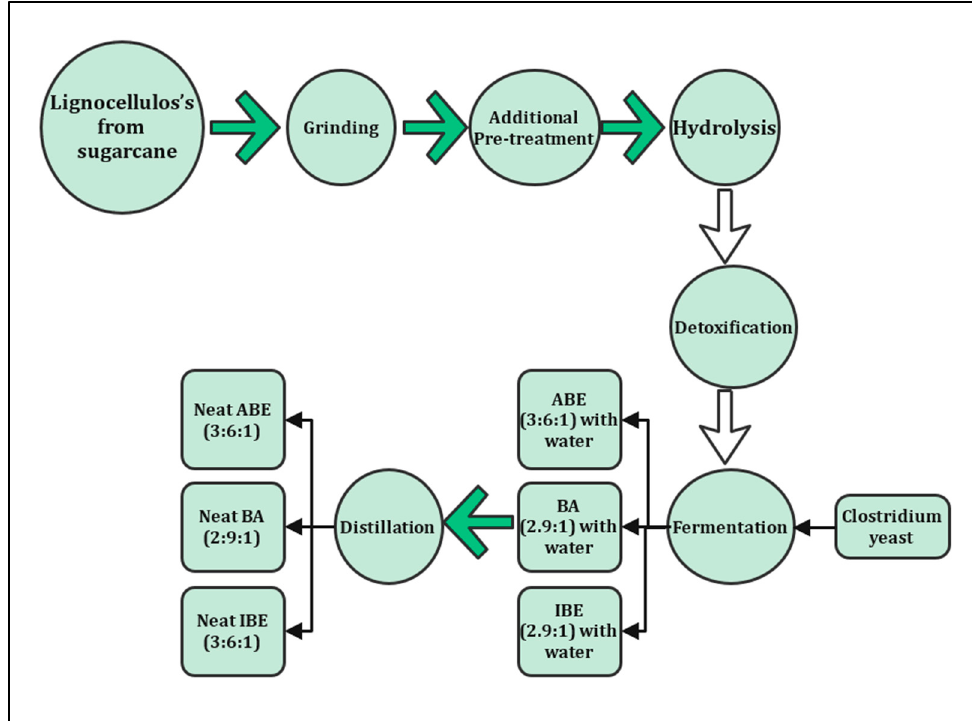
Figure 2. Production process of biofuel from sugarcane.